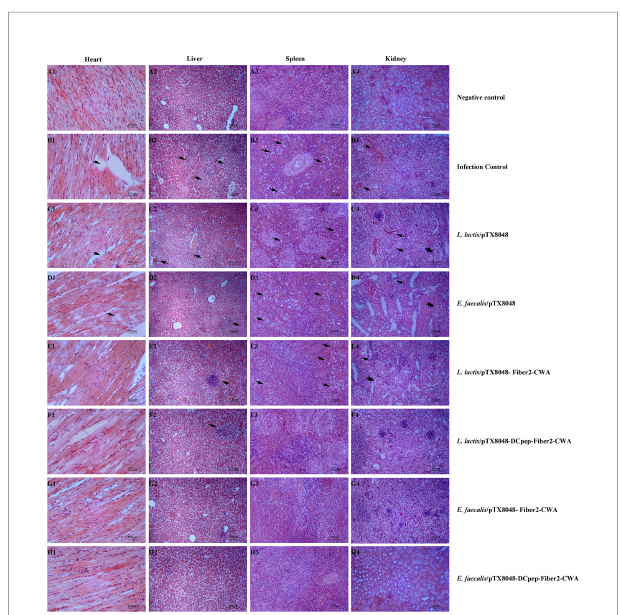
FIGURE 11 | Microscopic histopathological changes in chickens heart, liver, kidney, and spleen tissues from each group. Tissues of hearts, livers, spleens and kidneys from experimental chickens were collected and used to prepare histopathological slides. There are no apparent lesions in the heart, liver, spleen, and kidney in negative control (A1 – A4) . On the contrary, in infection control, L. lactis /pTX8048 and E. faecalis /pTX8048 groups showed noticeable lesions. These lesions involve myocardial fi ber rupture in cardiac tissue as indicated by arrows, hepatocyte necrosis and in fl ammatory cell in fi ltration in liver tissue (arrows), focal necrosis of splenocytes (arrows), tubular epithelial cell shedding, and interstitial congestion (arrows) in renal tissue (B – D) . Compared with the control group, the other four challenged groups had relatively fewer lesions (E – H)